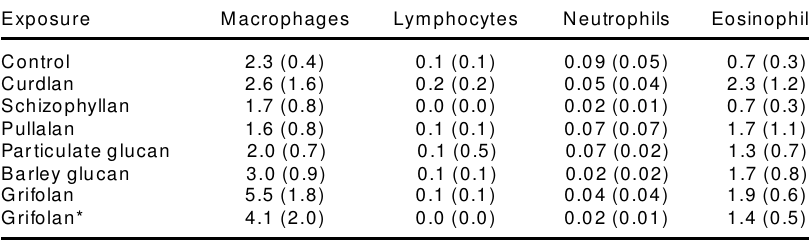
Table 1. Inflammatory cells ( ´ 10 6 /g lung) in lung lavage 24 h after exposure to different forms of (1 ® 3)- b - D -glucan (100 m g/ml) Exposure